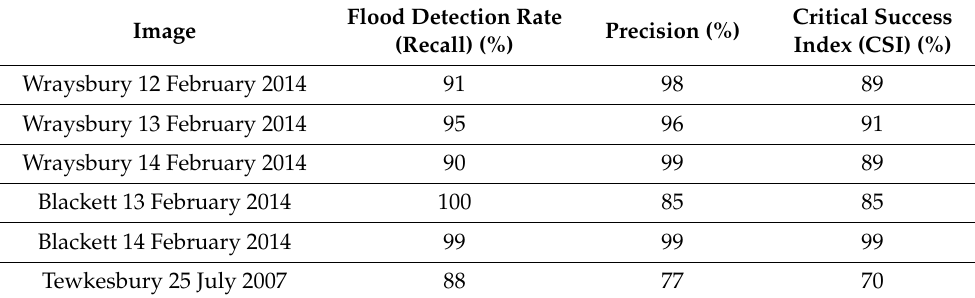
Table 2. Urban flood detection accuracy using rural SAR WLOs only.